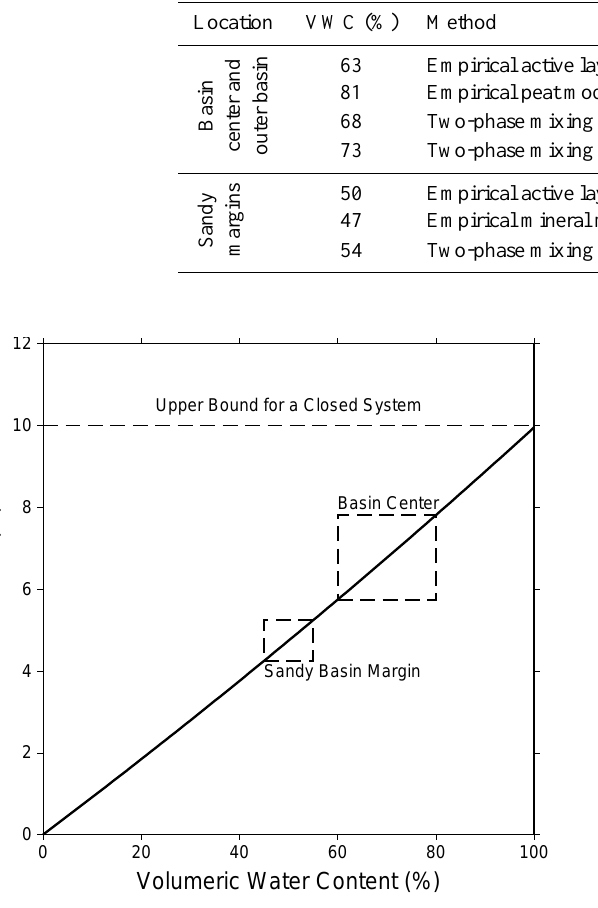
Fig. 5. Theoretical relation between the thaw strain and the volu- metric water content when freezing and thawing of the soil occurs in a closed system. Thaw strain has an upper bound of 10%. The two boxes outline the ranges of thaw strains and volumetric water contents for the sandy margins and the center of SAC basin, respec- tively.